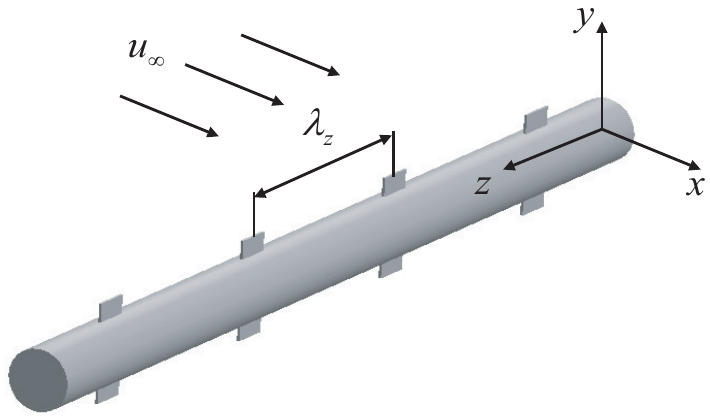
Figure 2. Schematic diagram of a circular cylinder attached by multiple tabs installed at θ t = 90 ◦ with the free-stream velocity u ∞ . λ z denotes the spanwise distance between adjacent